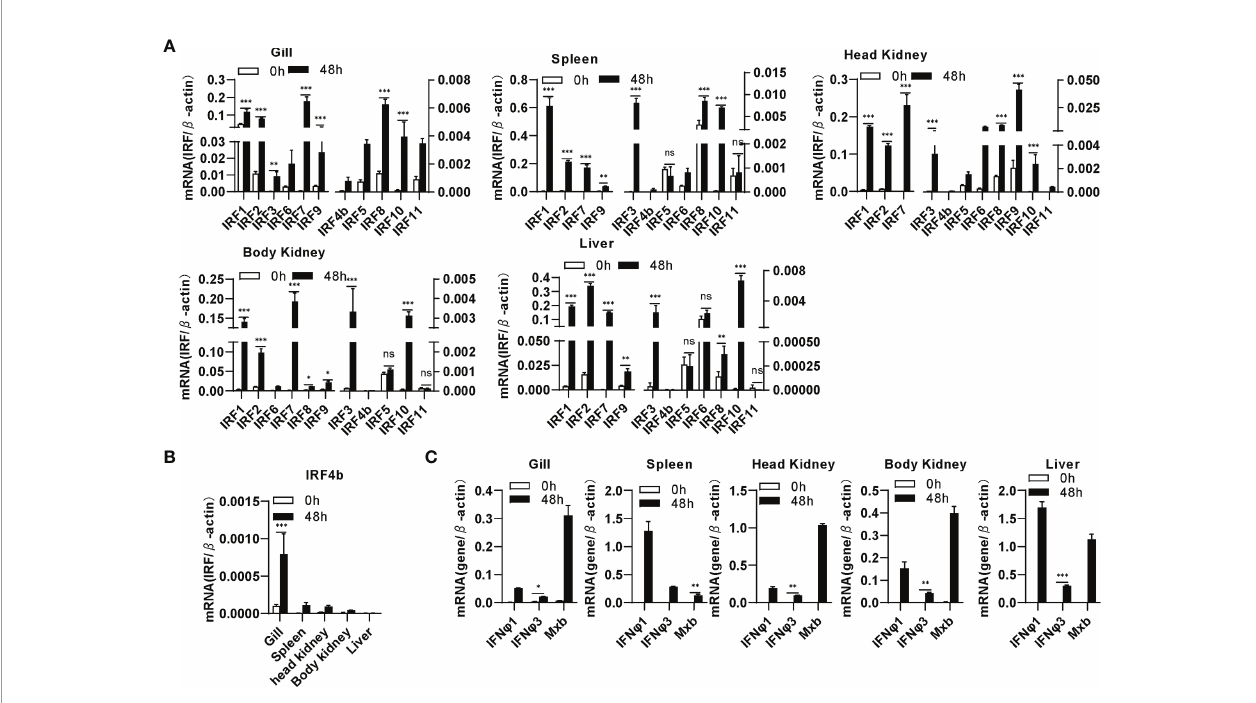
FIGURE 1 | Zebra fi sh IRF family genes are transcriptionally induced in zebra fi sh tissues by SVCV infection. zebra fi sh adults were intraperitoneally injected with SVCV virus of 1×10 7 TCID 50 /ml (25 m L/ fi sh). 48h later, fi ve tissues, including gill, spleen, head kidney, body kidney, and liver, were sampled for extraction of total RNAs followed by qRT-PCR analyses of 11 zebra fi sh IRF family genes (A) , zebra fi sh IRF4b (B) , and zebra fi sh IFN j 1, IFN j 3 and Mxb (C) . The relative expression values of a given gene were normalized to b -actin in the same sample. Error bars represent SDs obtained by measuring each sample in triplicate. (***P < 0.001, **P < 0.01, *P < 0.05, ns, no signi fi